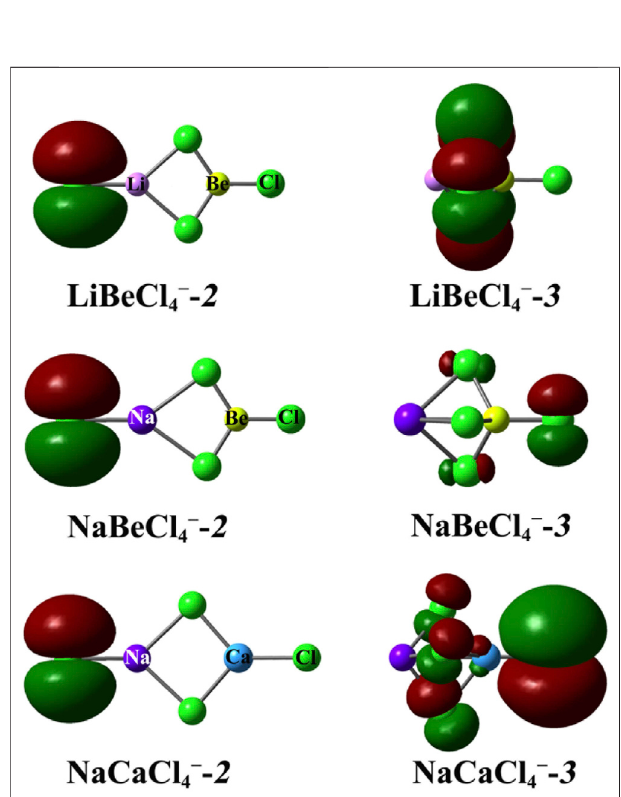
FIGURE3| HOMOorbitalsofsuperhalogen anionsLiBeCl 4 − ,NaBeCl 4 − , and NaCaCl 4 − .Color legend: green for Cl atom, light purple for Li atom, dark purple for Na atom, and blue for Ca